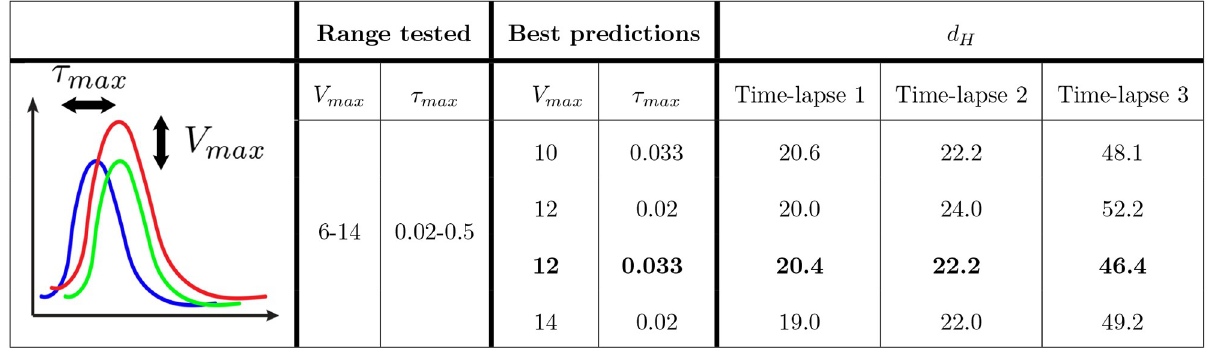
and τ . Four best predictions from the grid search and their Hausdorff max max